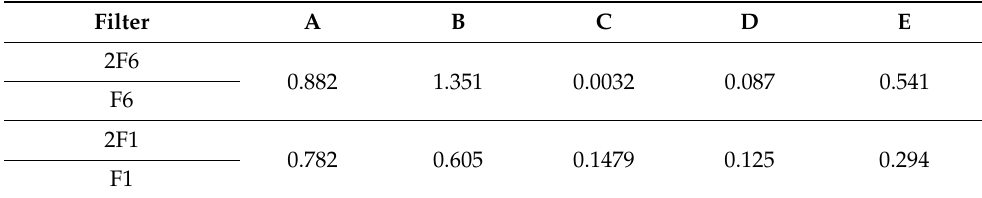
Table 3. The efficiency equations coefficients